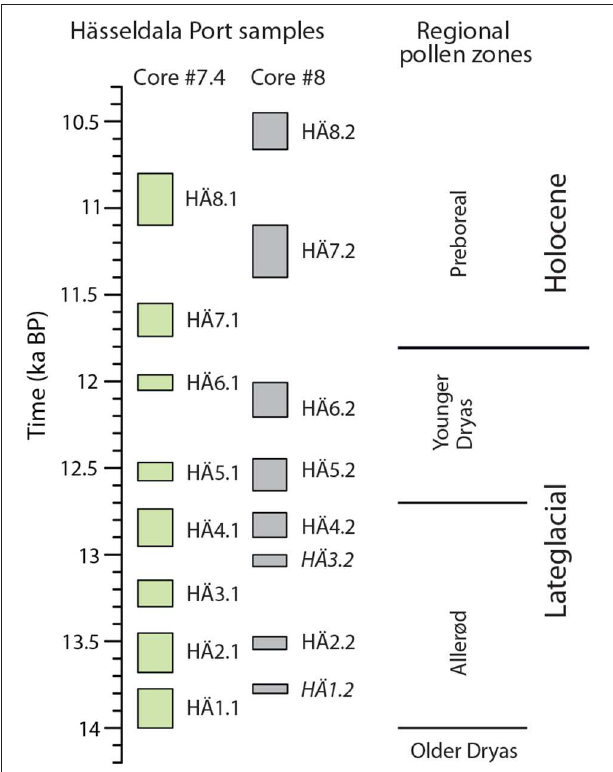
FIGURE 2 | The 16 samples analyzed for eDNA, pollen and plant macrofossil remains in cores #7.4 (green) and #8 (gray) from Hässeldala Port shown on an age scale and in relation to the regional pollen zones. Sample IDs shown in italics represent DNA samples of poor quality, which were excluded from DNA assignments.